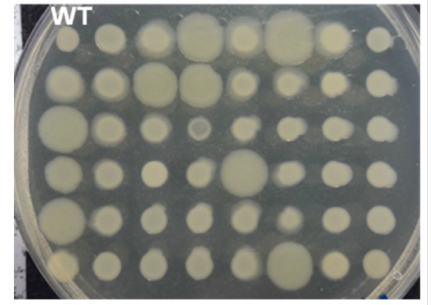
Figure 2. Screening of Pseudomonas syringae transposon disruption mutants for changes in colony morphology. Tn mutant colonies (48) were inoculated onto standard agar plates and changes in colony morphology recorded after 72 h, Colonies were replica plated in a 48 grid pattern with the wild-type (WT) strain at position 1. Plate contains 47 P. syringae pv. morsprunorum R2 MH001 transposon